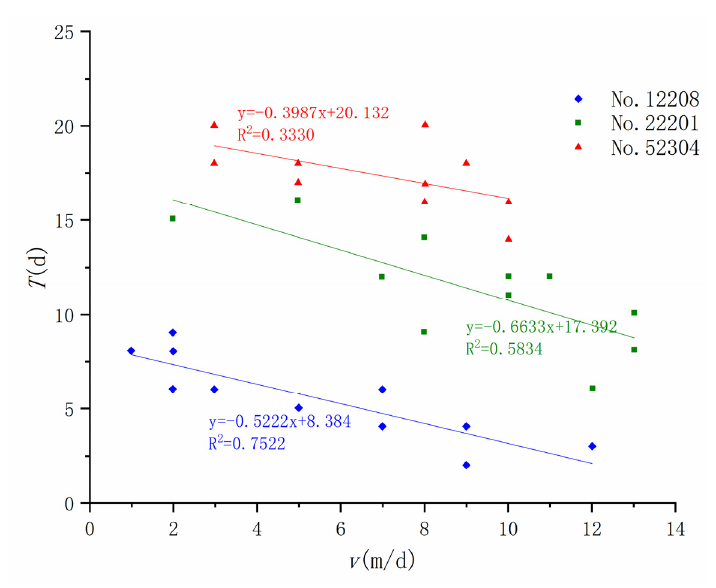
Figure 10. Relationship between ground fissure advance rate v and cycle time T.